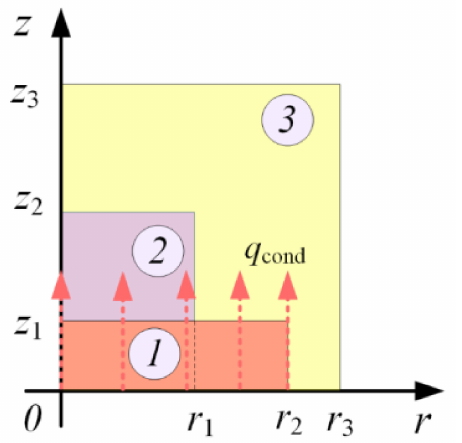
Figure 1. Scheme of the solution domain for the heat and mass transfer problem under conductive heating: 1 —heating surface; 2 —gel fuel sample; 3